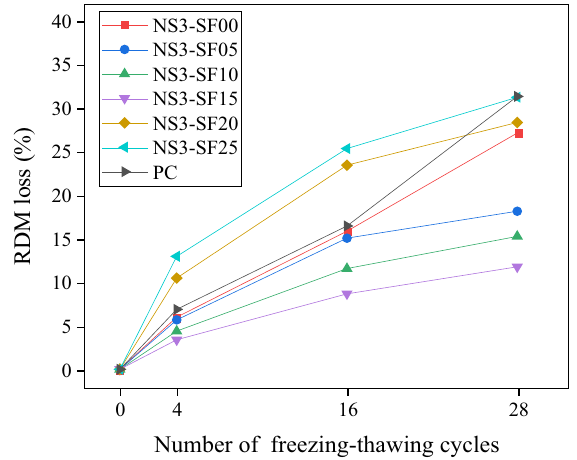
Figure 14: E ff ect of SF content on relative dynamic modulus after freeze – thaw cycles.